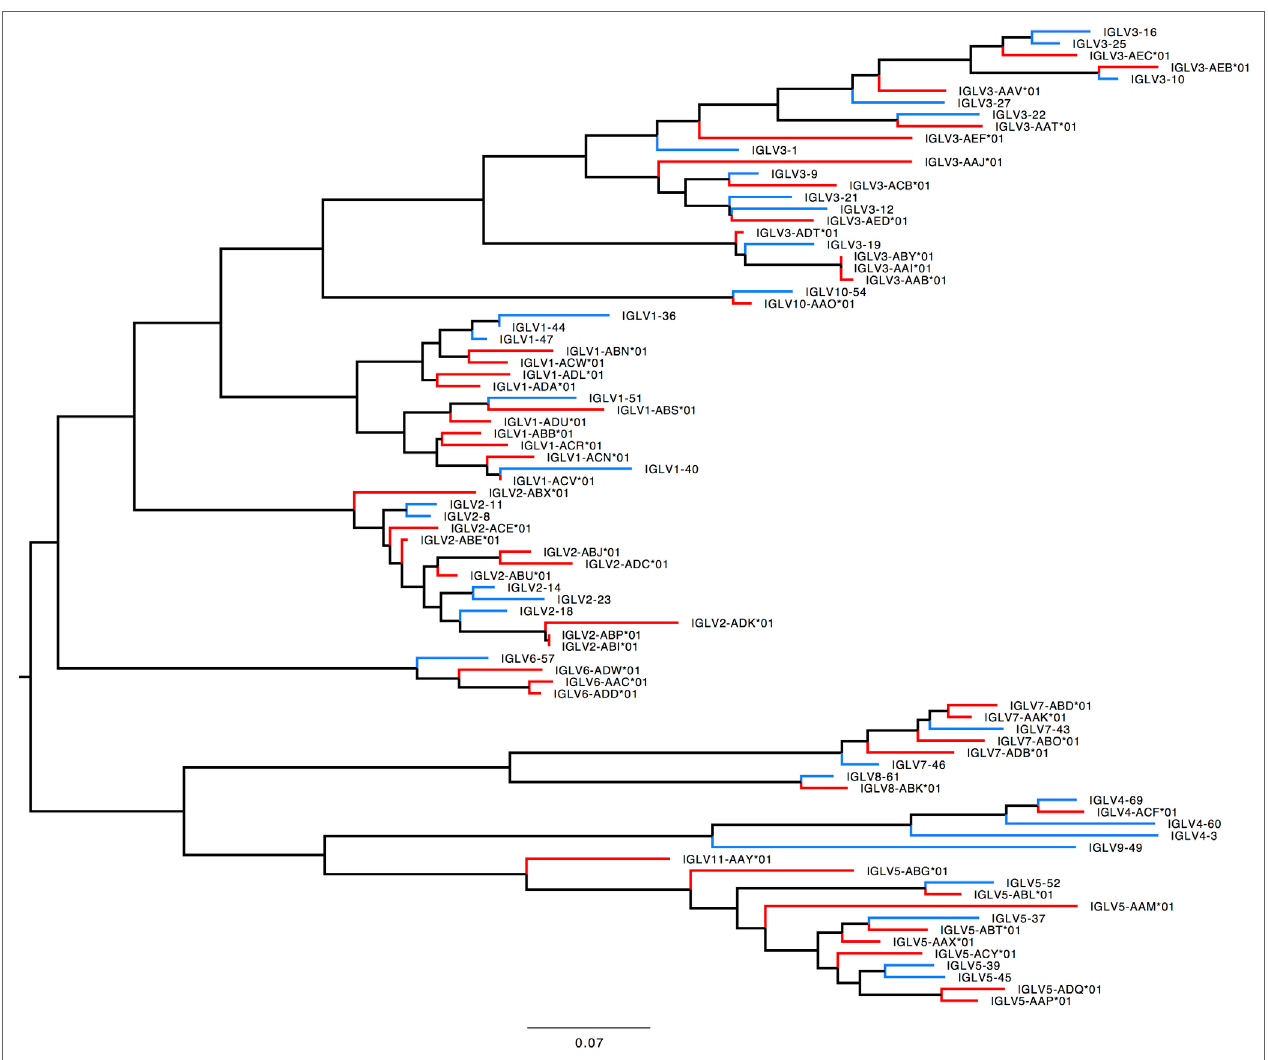
FigUre 9 | Maximum likelihood phylogenetic tree of the human and rhesus IGLV functional genes. Human immunoglobulin (Ig) V genes are represented in blue and macaque Ig V genes in